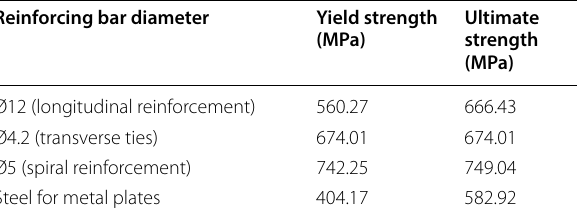
Table 3 Reinforcement and steel plates